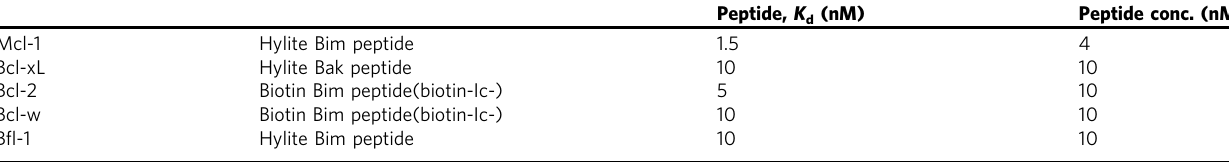
Table 2 TR-FRET assay-binding parameters of Bim or Bak peptides to Bcl-2 pro-survival proteins used in K i calculations